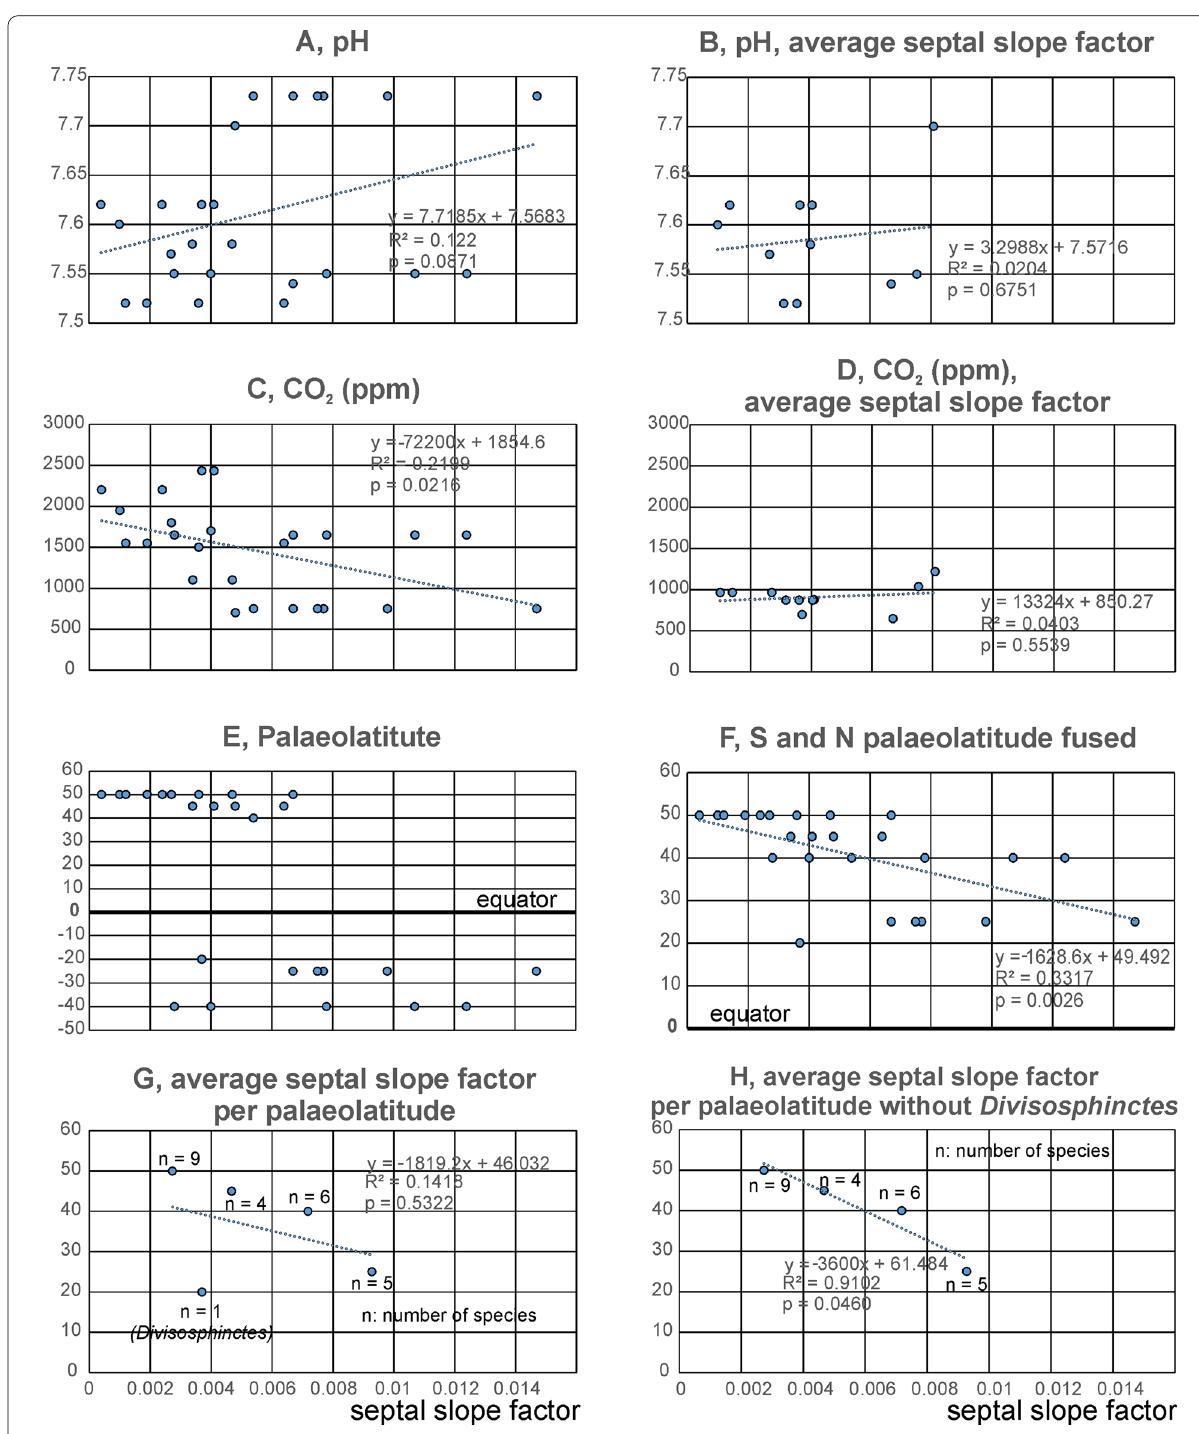
Fig. 9 Correlation of abiotic factors (vertical axes) with the septal slope factor (horizontal axis). A pH after Ridgwell (2005); B like A, but with average septal slope factors. C atmospheric CO 2 (Witkowski et al., 2018). D like C , but with average septal slope factors. E Palaeolatitudal distribution using the maps of Kocsis and Scotese (2021). F Like E , but northern and southern latitudes fused. G Like F , but with average septal slope factor per latitude. H Like G , but without the outlier